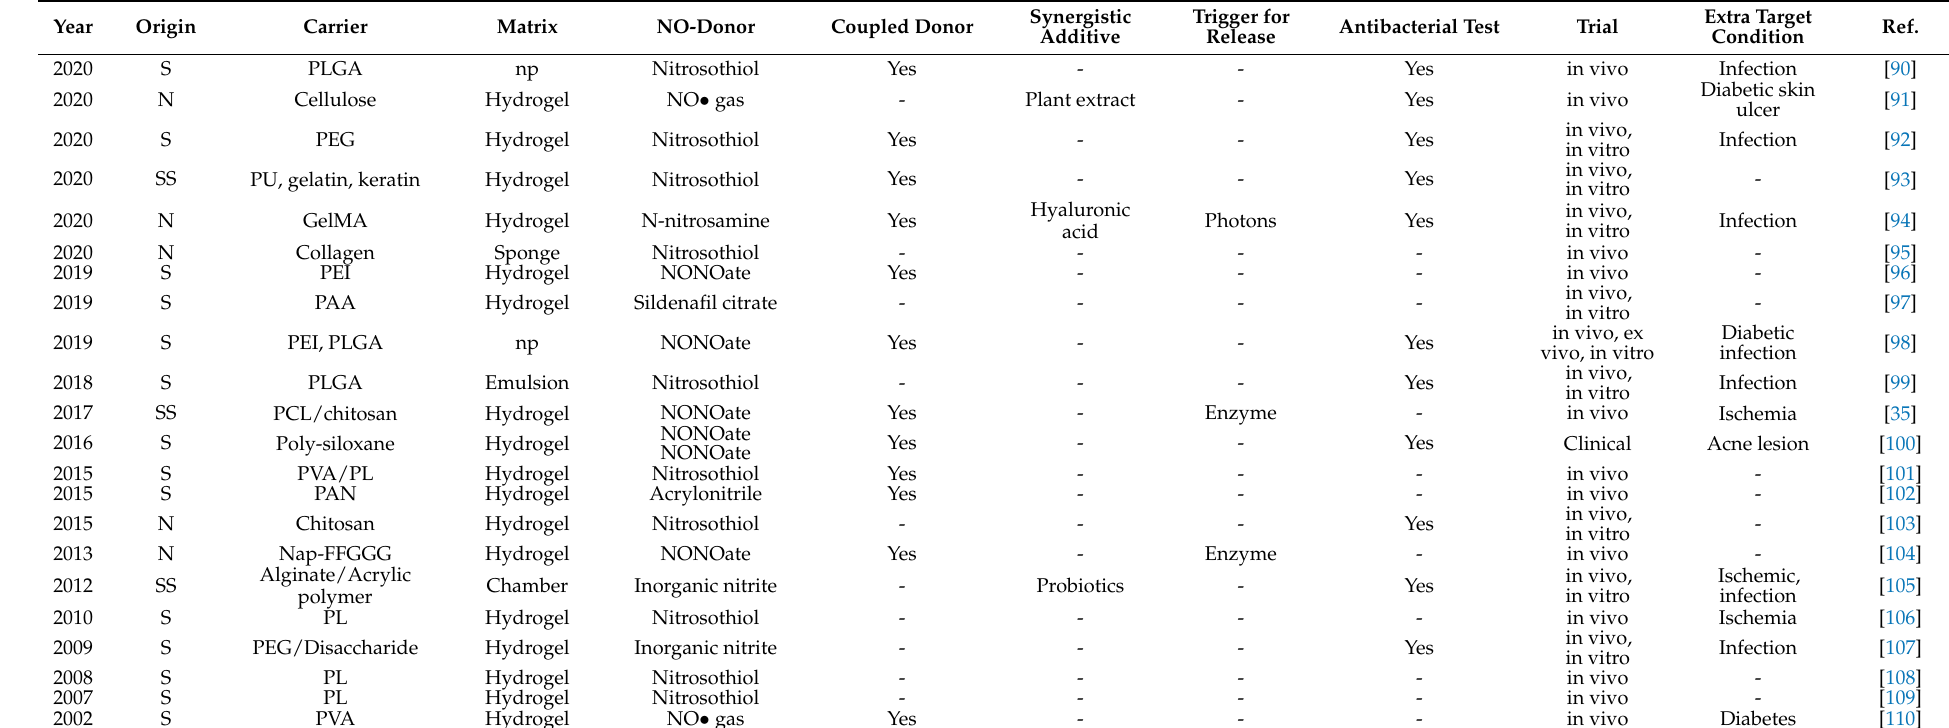
Table 3. Compilation of publications showing the evolution of NO-donor polymeric carriers intended to treat cutaneous